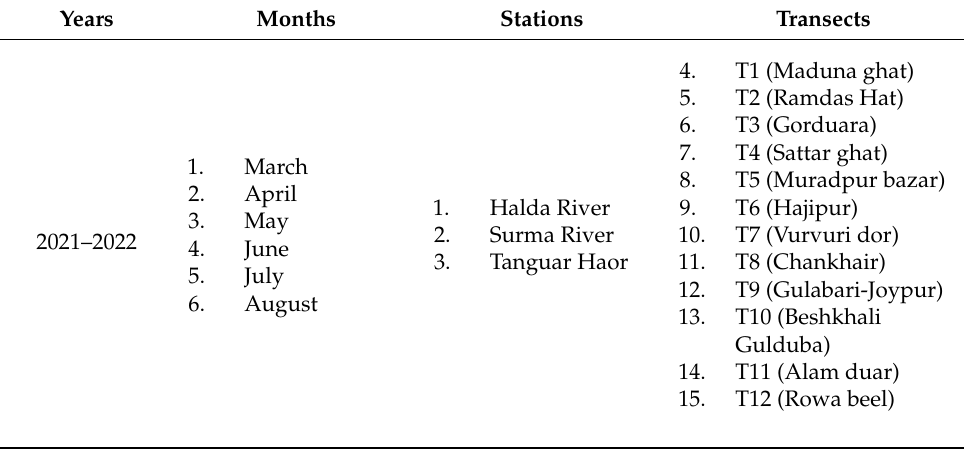
Table 1. Target list of the study duration and sampling